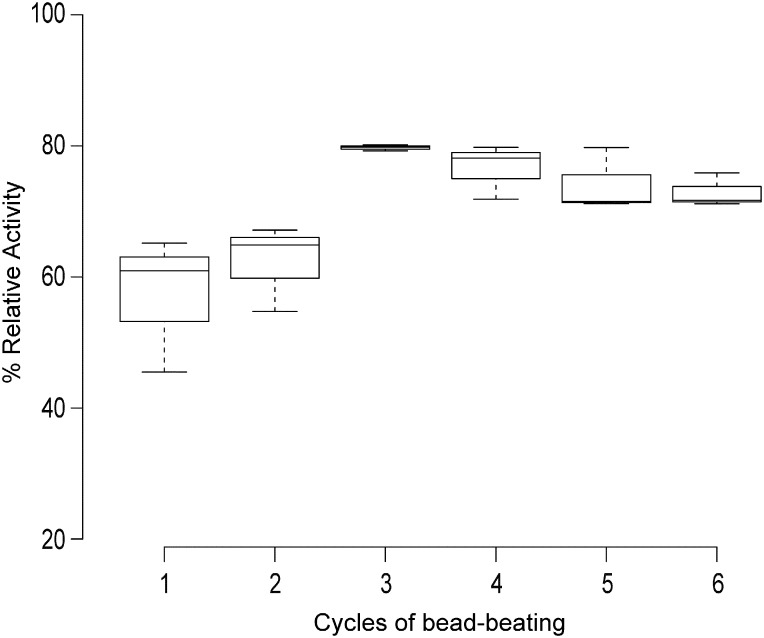
A boxplot of the mean of triplicate data + standard error of the means. Statistical significance was determined by non-parametric multiple comparison testing using a Holm adjustment method to control for familywise error rate. Significantly higher protease activity was observed after 3, 4, 5 and 6 rounds of bead beating (P = 0.0065, 0.0196, 0.0430 and 0.0639 respectively) when compared to 1 round of bead beating. Significantly higher activity was also observed after 3 rounds of bead beating compare to 2 rounds (P = 0.0377).